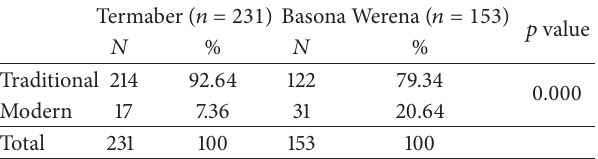
Table 2: Types of beekeeping methods in the study